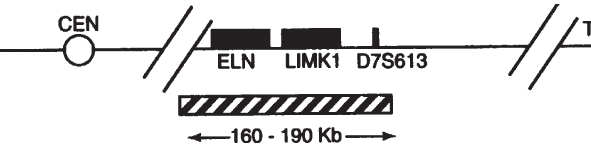
Figure 3 - a: Picture of FISH test for WS demonstrating metaphase with 2 red signals (elastin gene) and 2 green signals (markers of chromosome 7), therefore without elastin gene deletion (FISH-negative patient). b: Picture of FISH test for WS demonstrating metaphase with 2 green signals (markers of chromosome 7) and only 1 red signal (elastin gene); therefore, with deletion of the elastin gene (FISH-positive